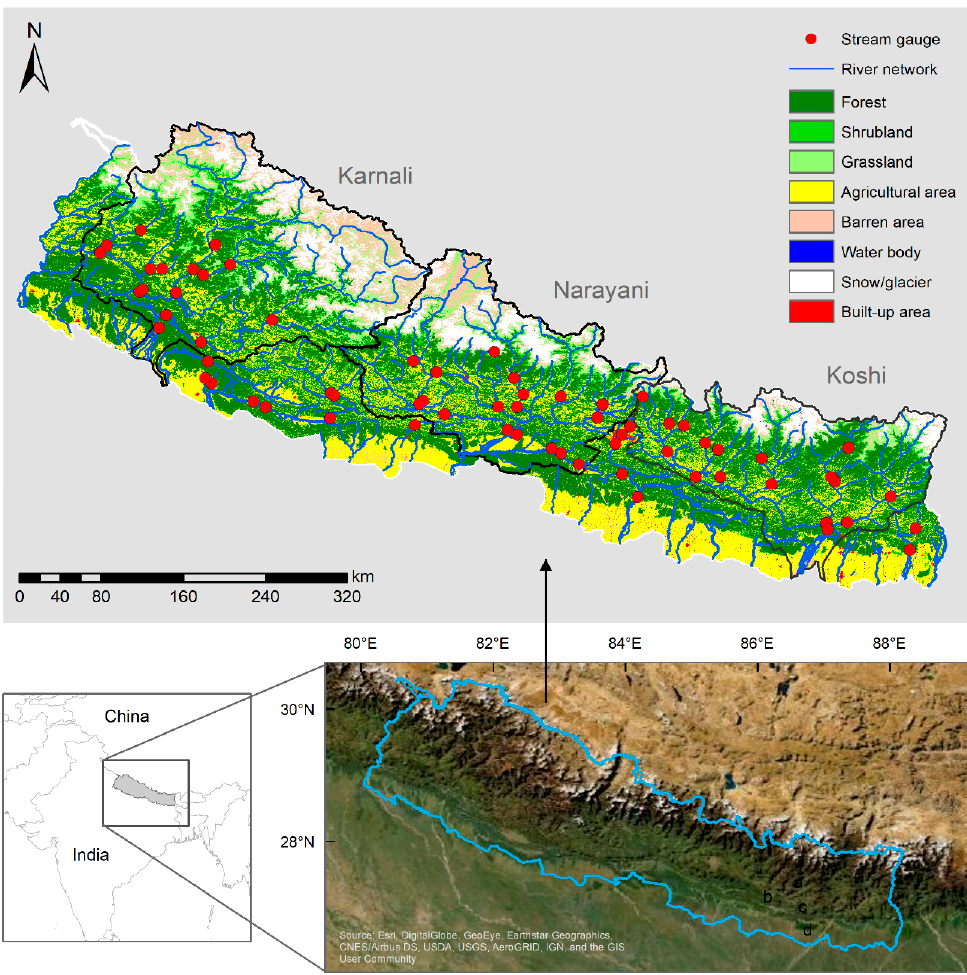
Figure 1. Location of the study domain, Nepal. The white patches in the terrain map (not to scale) depict the snow cover (Nepal Himalaya). The land cover is from Uddin et al. [29]. The red dots represent stream gauge stations monitored by the Department of Hydrology and Meteorology (DHM), Nepal.